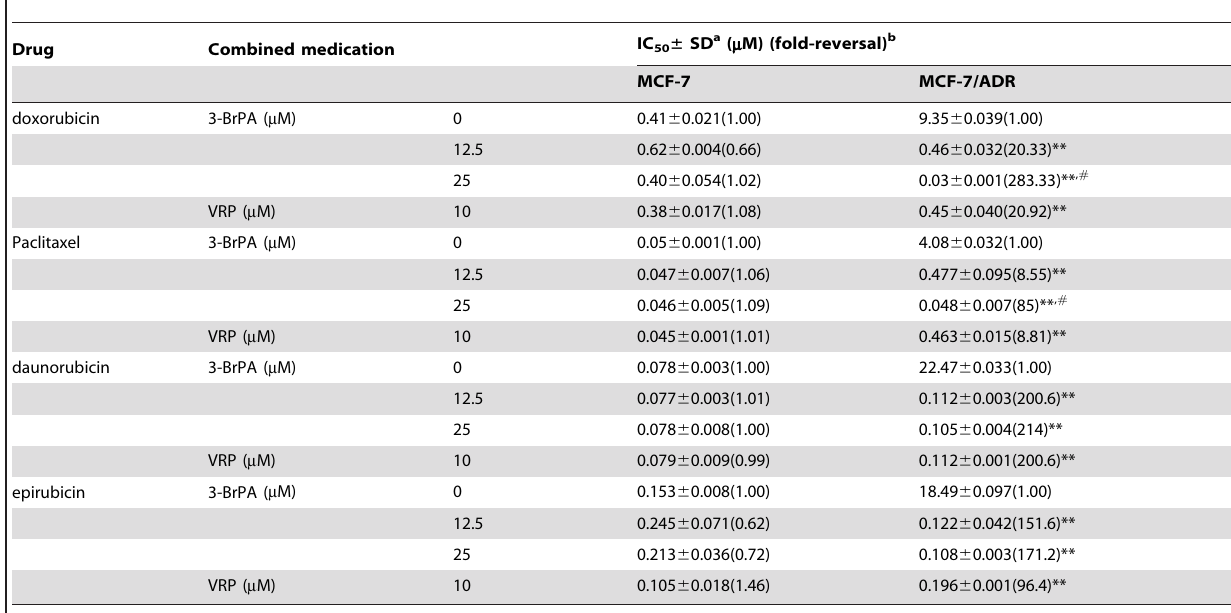
Table 2. Effect of 3-BrPA on reversing ABCB-1/P-gp mediated drug resistance in MCF-7 and MCF-7/ADR.